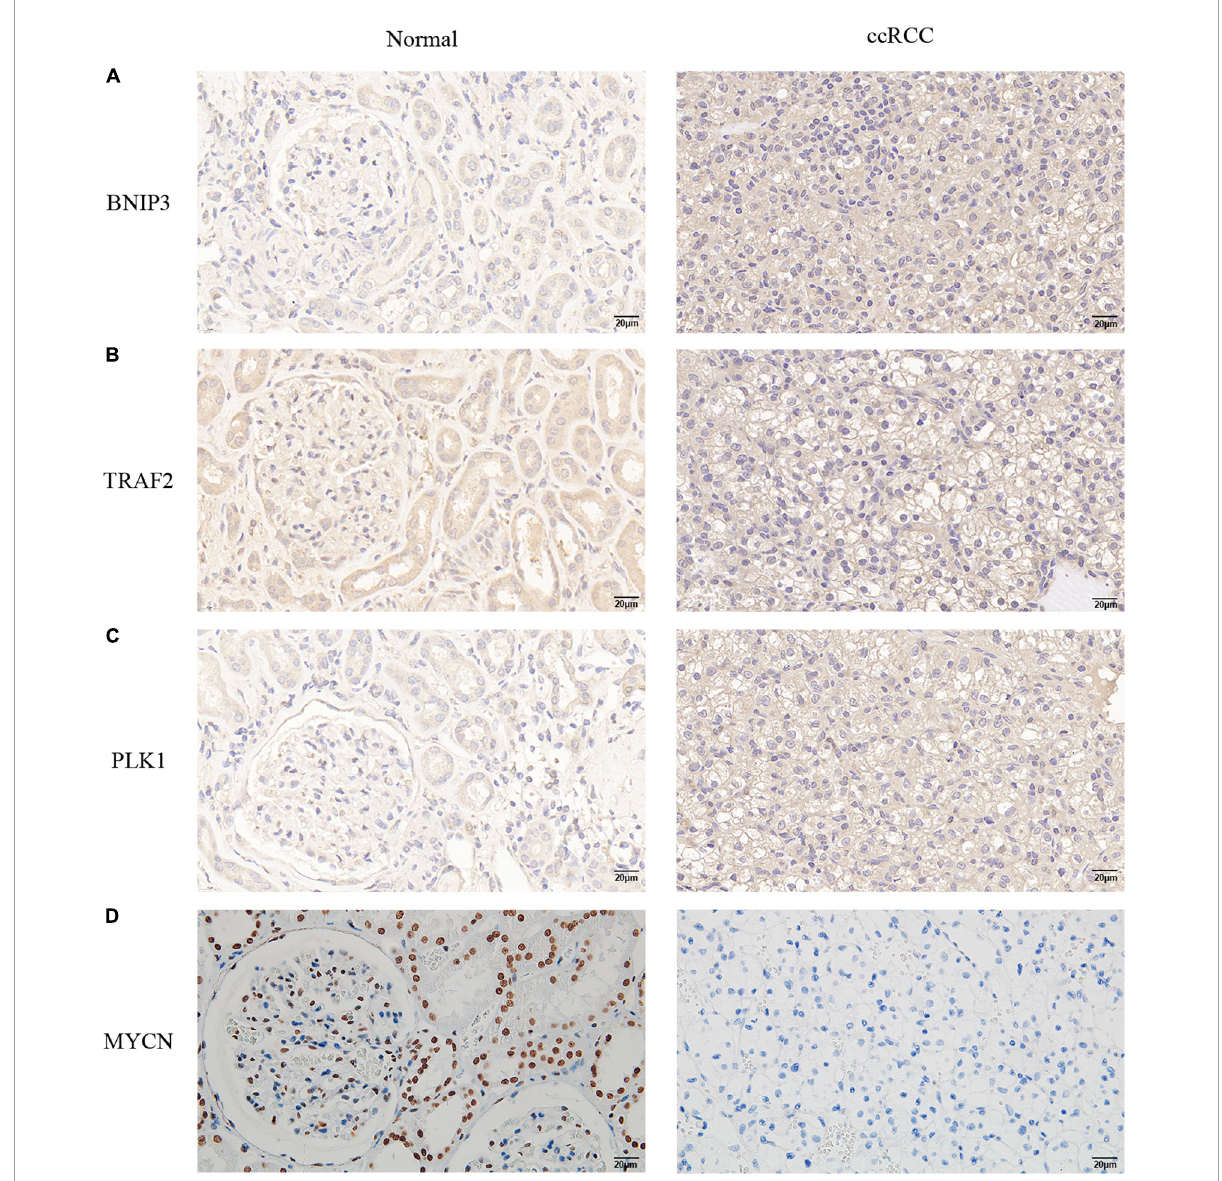
FIGURE10 Verification of the protein expression levels of the four NRGs in non-tumor tissues and ccRCC tissues. (A) BINP3, (B) TRAF2, (C) PLK1, (D)